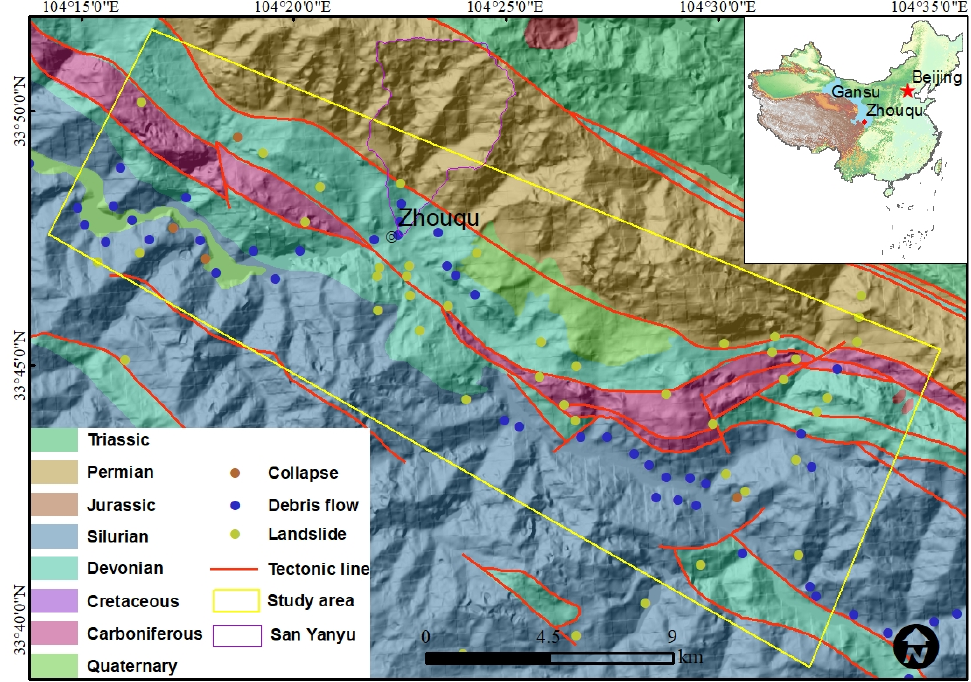
Figure 1. Study area location and geological